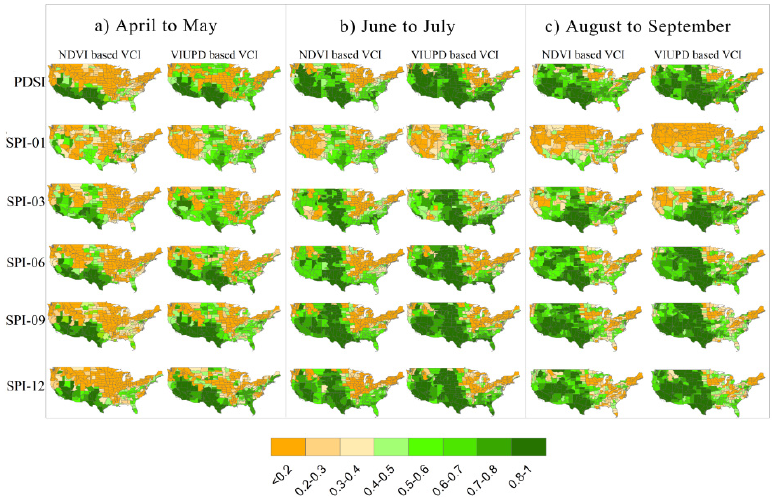
Figure 4. The number of climate divisions (CDs) passed at least p -value of 0.05 for testing statistical significance when comparing VI-based VCIs and station-based drought indices. X -axis stands for the station based drought indices which NDVI and VIUPD-derived VCIs are correlated to. Y -axis stands for the number of CDs which passed at least p -value of 0.05 for testing statistical significance.